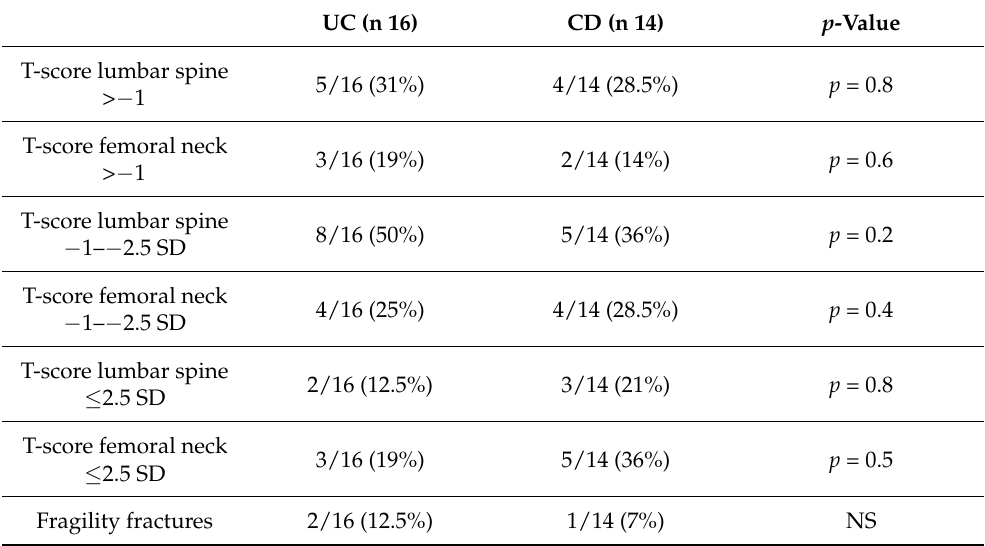
Table 6. Distribution of BMD T-score alterations among patients with UC and CD of group